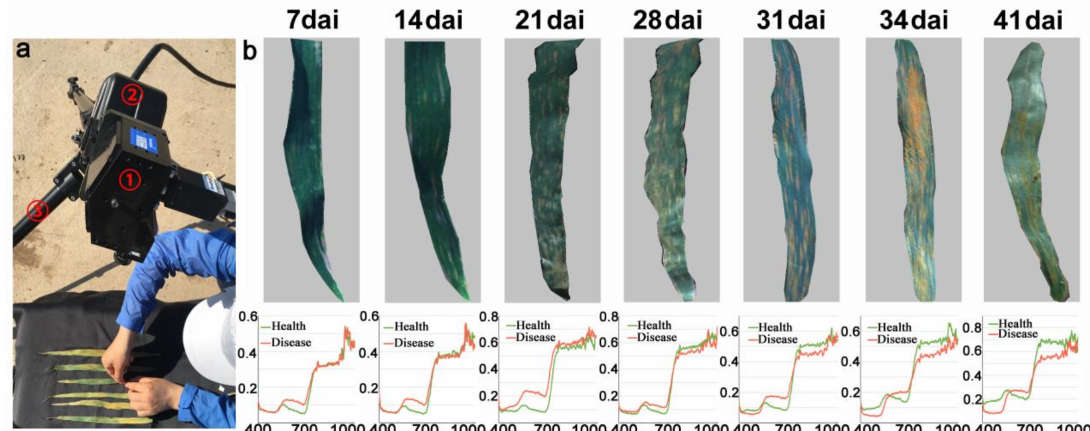
Figure 1. ( a ) The setup of the Headwall system: 1 (cid:13) . Headwall visible to near infrared (VNIR) imagining sensor; 2 (cid:13) . Pan & Tilt; 3 (cid:13) . The tripod. ( b ) The true color composite image of the leave composited by raw hyperspectral images. The second row shows the comparison of spectral reflectance between the healthy area and diseased area of the